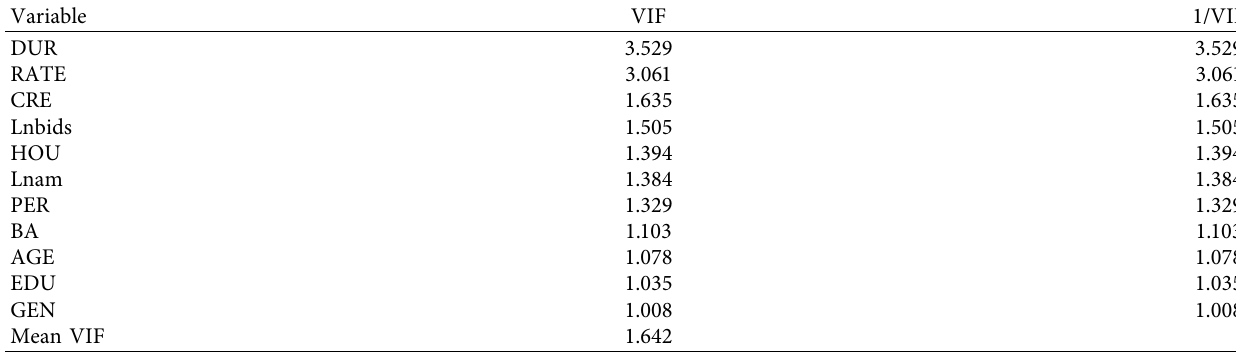
Table 3: Result of the VIF